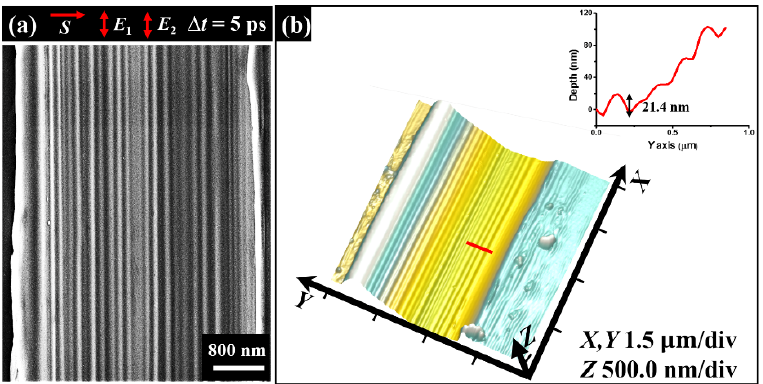
Figure 6. Observed formation of the multiple regular nanowire structures within a wide groove of 3.6 μ m under irradiation of femtosecond laser pulses. ( a , b ) SEM and AFM images, respectively. Upper-right inset in ( b ) reveals the measured height of the nanowire structures marked by the red line in AFM image.